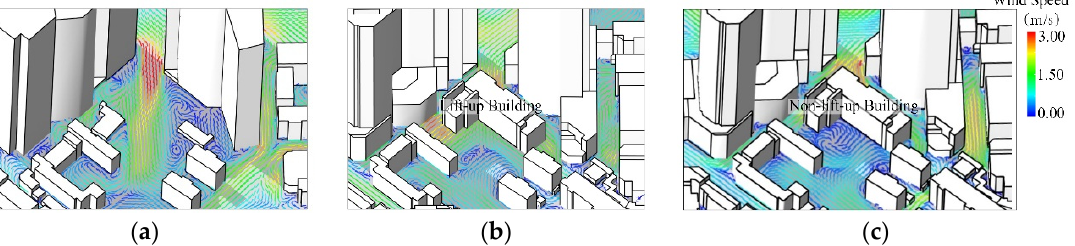
Figure 16. The wind environment of Chibi Road Primary School (Shanxi Road Campus) in summer: ( a ) 1990s; ( b ) 2010s; ( c ) no-lift-up building scenario simulation in the 2010s.